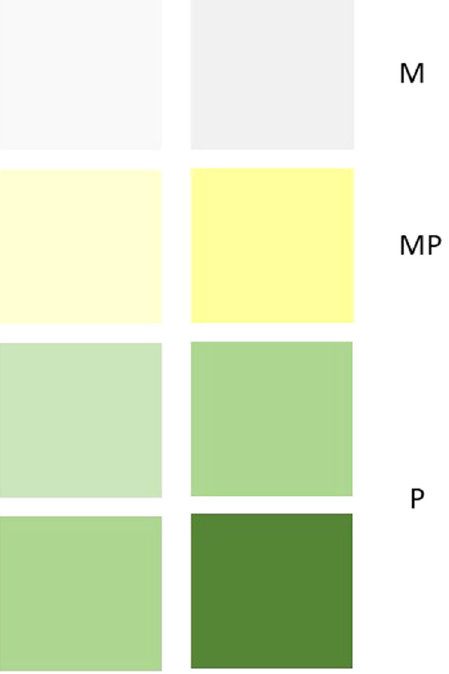
Fig. 4 Table to assess the colour of sputum from least to most purulent. Murray´s colorimetric scale is a very simple tool to assess the in fl ammatory component of the sputum and the response to treatment. Modify from Murray et al. Eur. Respir. J. 34 , 361 – 364